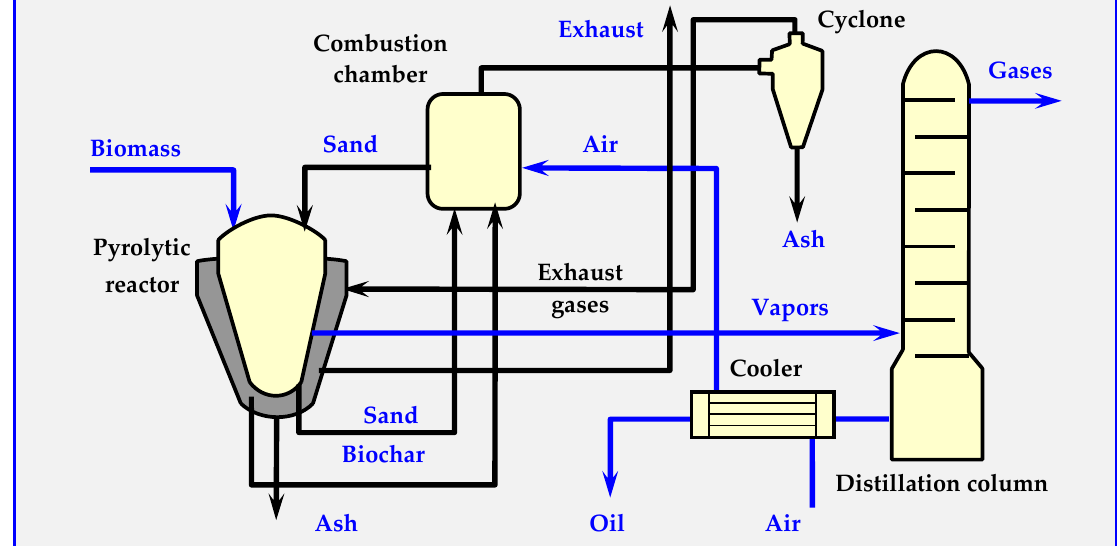
Figure 17. Technological diagram of the BTG flash pyrolysis process [17,117].